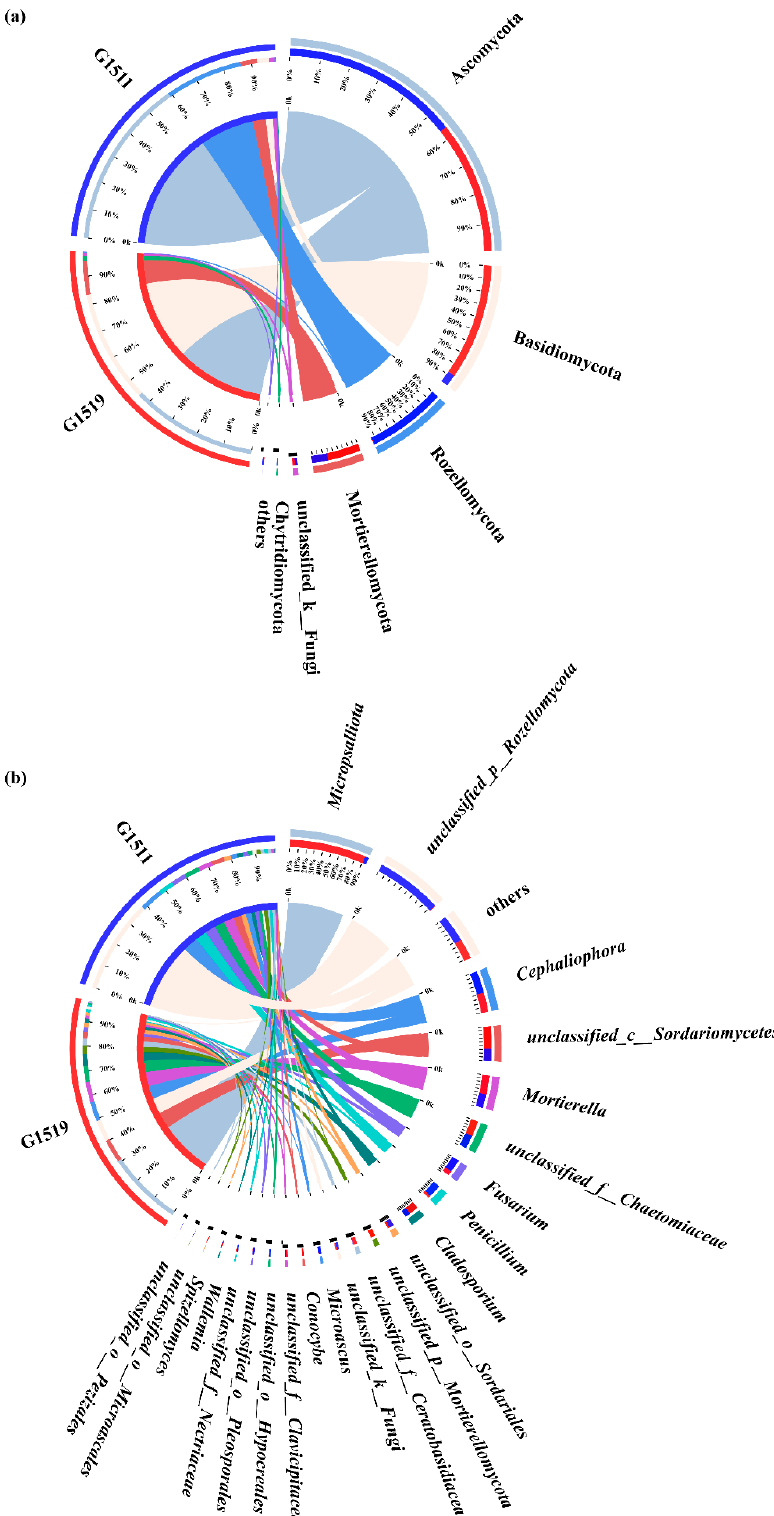
Figure 4. Compositions of soil fungal communities in the two pumpkin cultivars (G1519 and G1511) at the phylum level ( a ) and genus level ( b ).